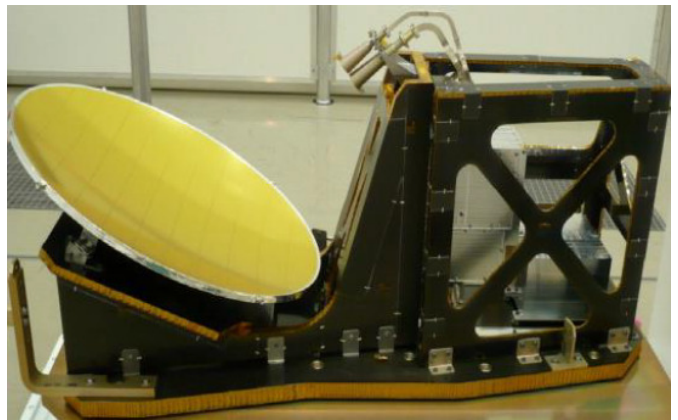
Figure 1. Photo of the MWR antenna plus two feed horns. Source: Sentinel-3 SRAL Marine User Handbook [1].